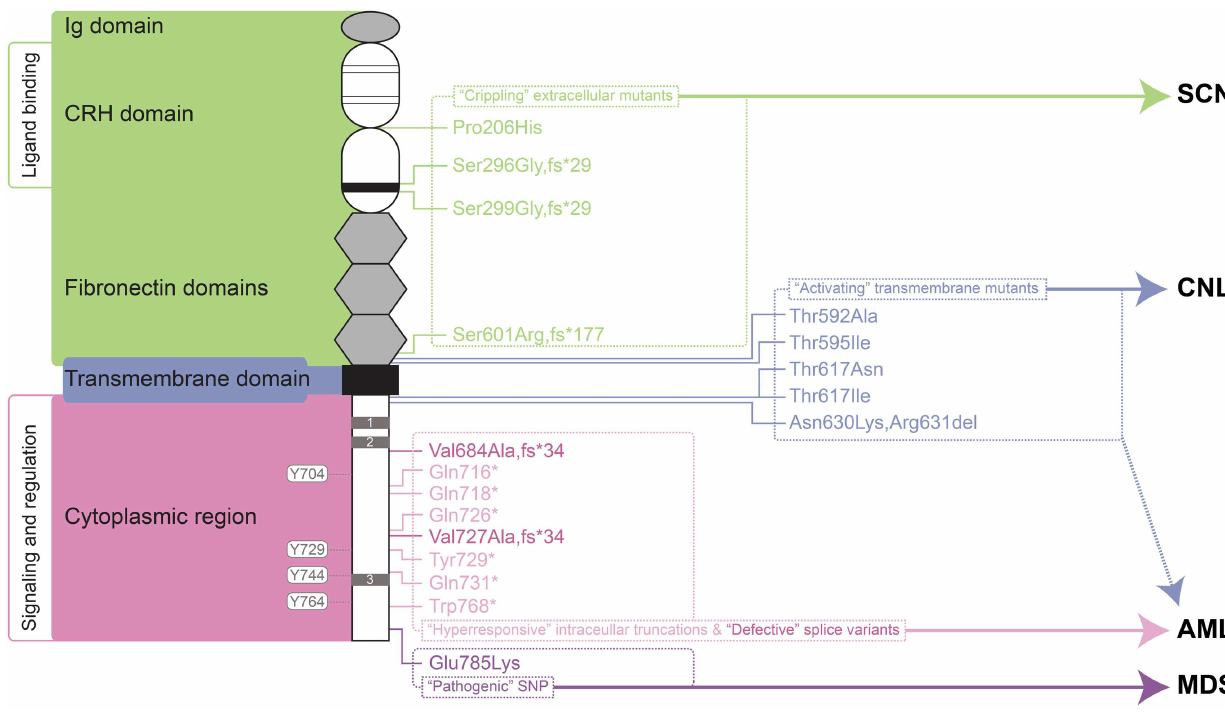
FIGURE 1 | Granulocyte colony-stimulating factor receptor perturbations in disease . Schematic representation of the mature G-CSFR (RefSeq NP_000751.3), showing important subdomains and residues conserved among members of the hematopoietin receptor superfamily, including the N-terminal Ig domain, four conserved cysteines (thin line), andWSXWS motif (thick line) within the CRH domain, fibronectin, and transmembrane domains as well as Box 1–3 (gray